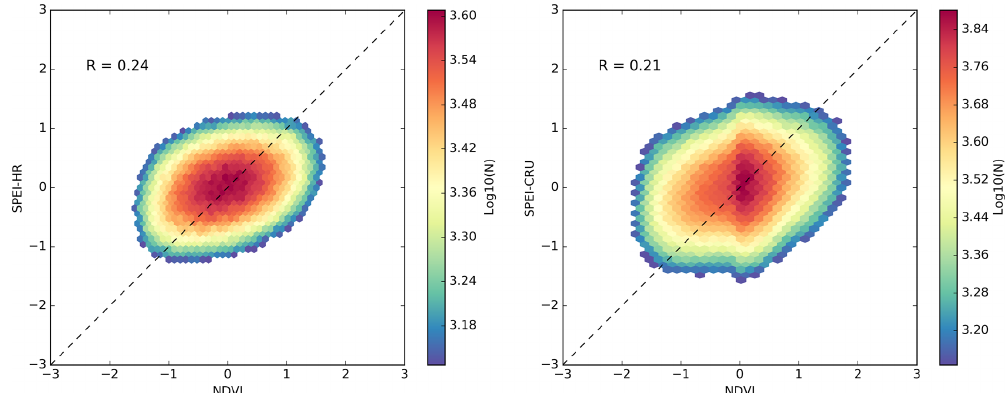
Figure A3. Scatter plots between 6-month SPEI and NDVI for the entire data record. R is correlation coefficient with p < 0 . 05, and the colours denote the occurrence frequency of